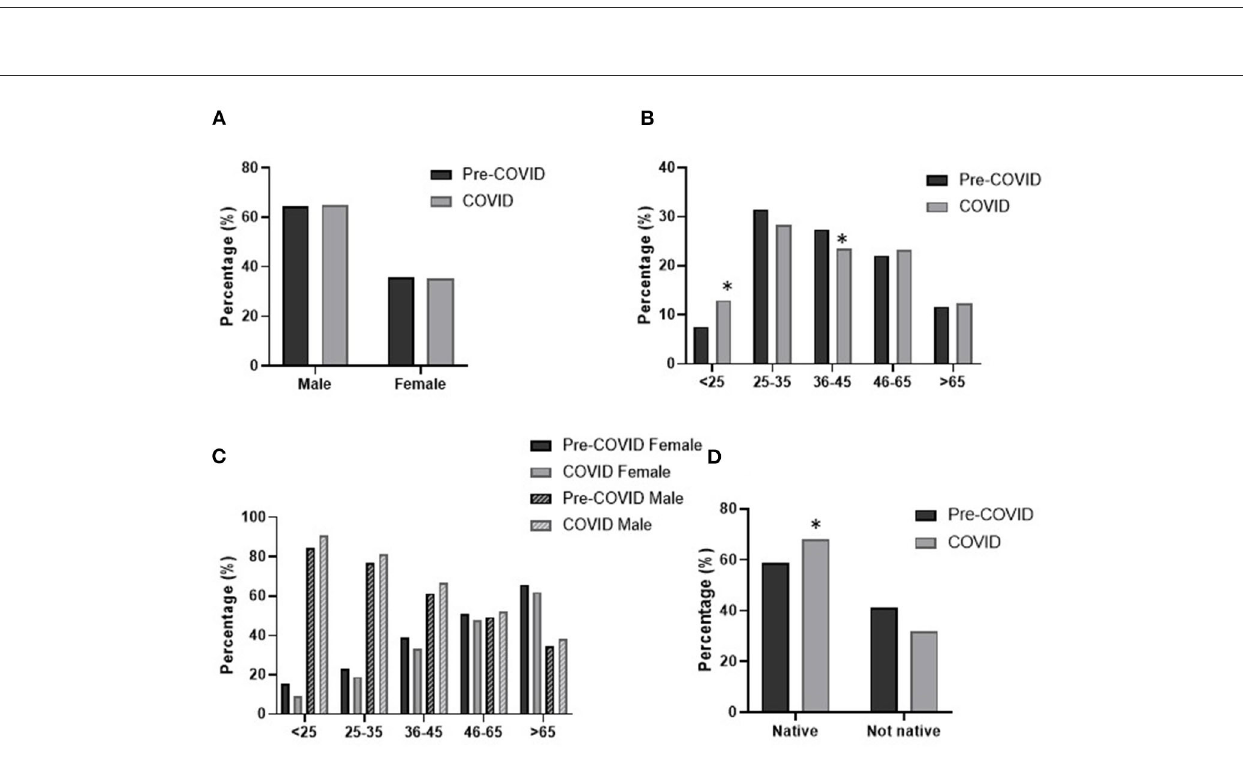
FrontiersinPublicHealth